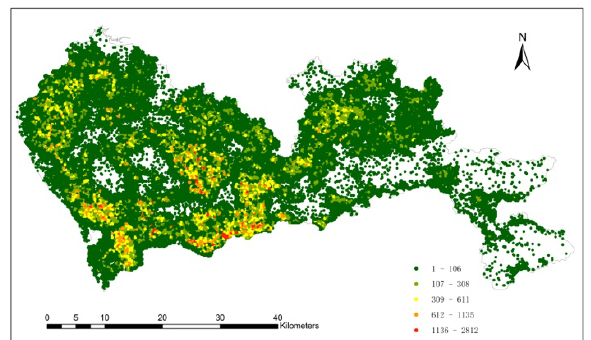
Figure 2. The distribution of the volume of mobile devices in Shenzhen (2017,